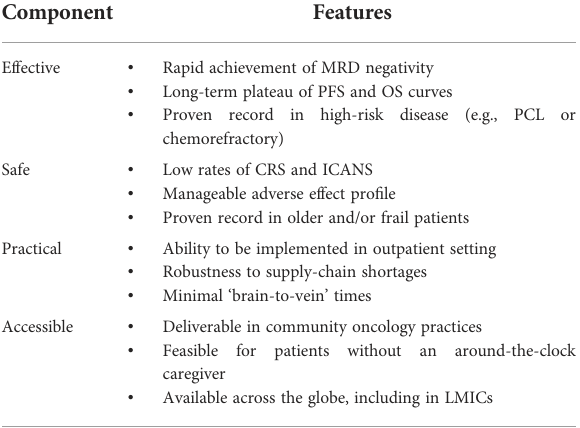
TABLE 4 Attributes of the ‘ Perfect ’ BCMA CAR-T